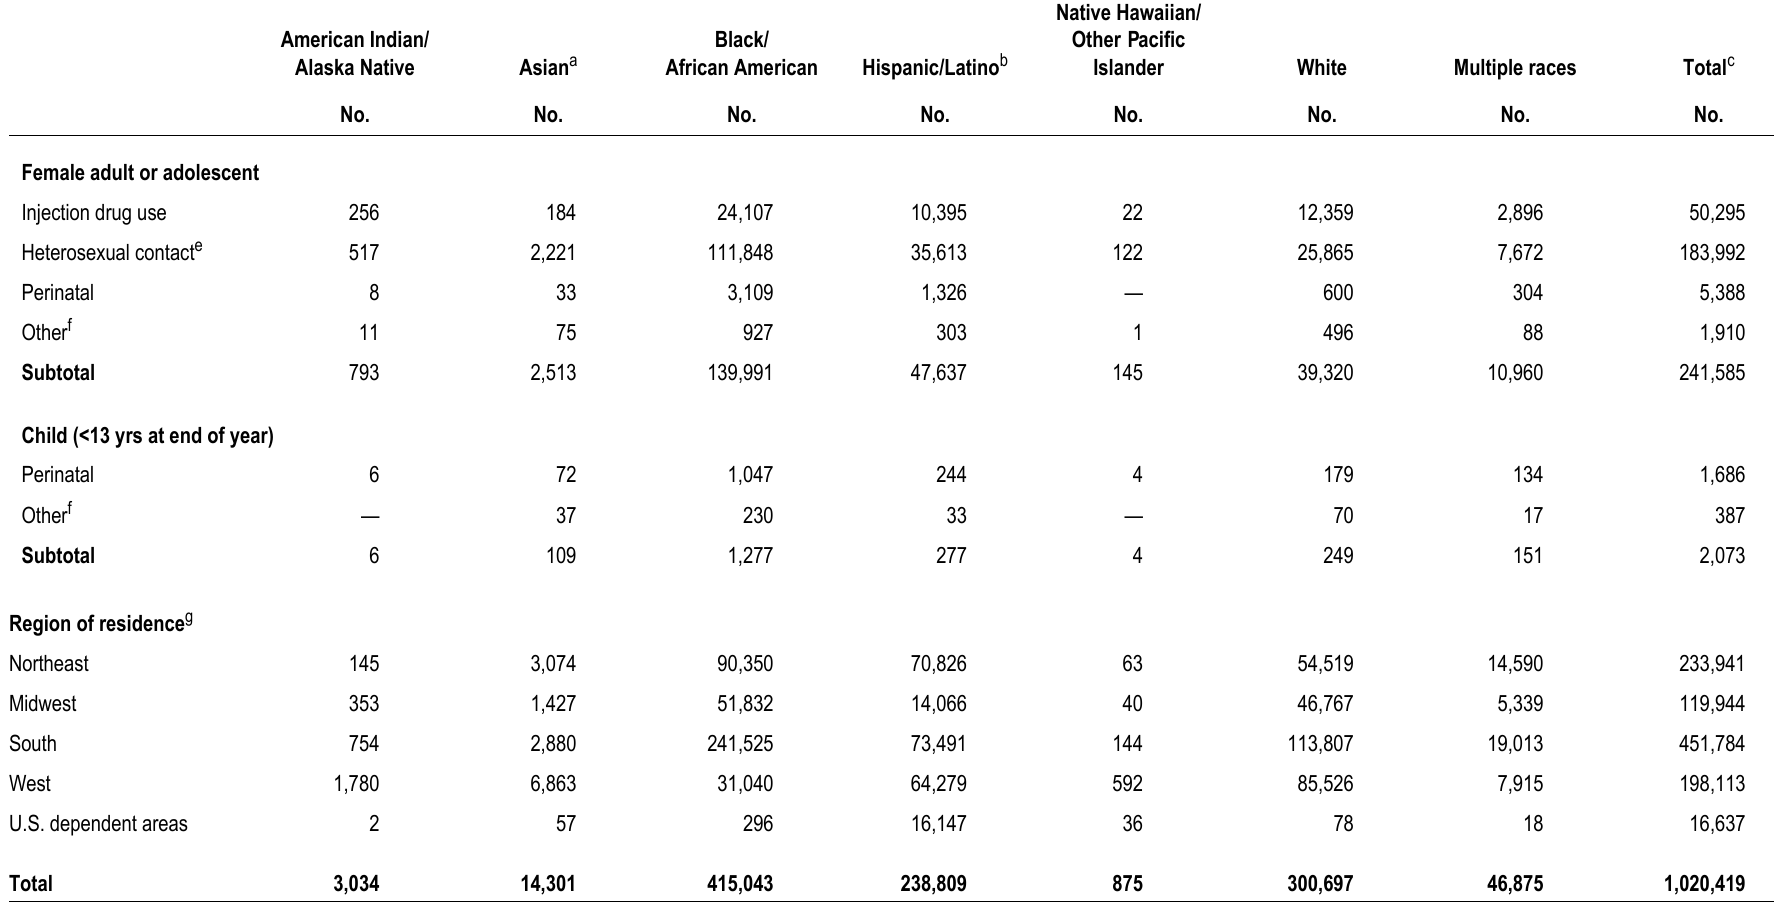
Table 24b. Persons living with diagnosed HIV infection, by race/ethnicity and selected characteristics, year-end 2017—United States and 6 dependent areas